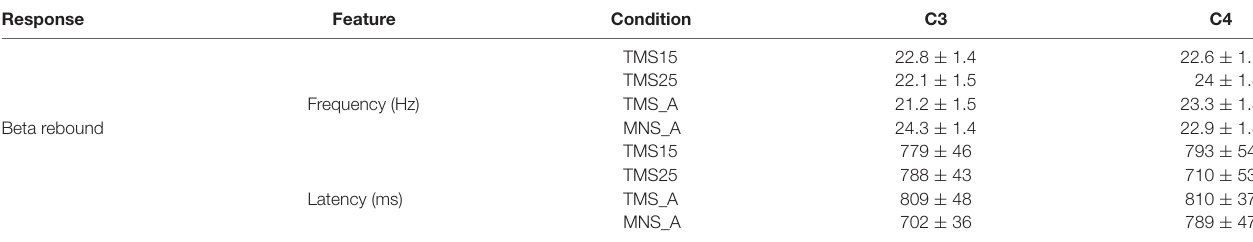
TABLE 1 | Peak frequency and peak latency of the beta rebound, respectively, for electrodes C3 and C4.